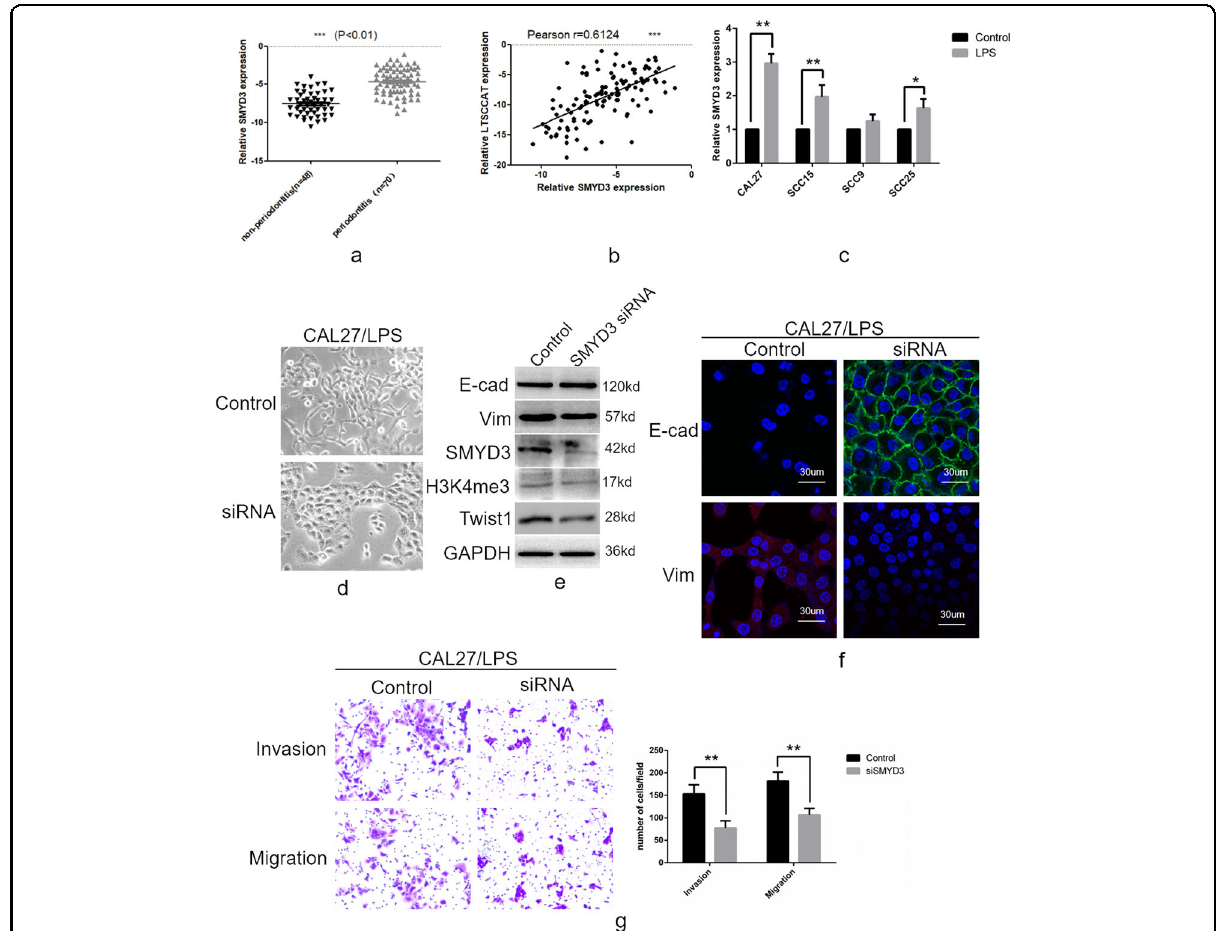
Fig. 4 SMYD3 promotes epithelial – mesenchymal transition in tongue squamous cell carcinoma. a The expression of SMYD3 in clinical specimens was detected by RT-QPCR, indicating that SMYD3 expression in TSCC tissues is higher in patients with periodontitis than in those without periodontitis. (** P < 0.01). b Correlation analysis between LTSCCAT and SMYD3 was performed in TSCC tissues. (** P < 0.01). c The expression of SMYD3 was reduced in the P.g-LPS-induced TSCC cell lines CAL27, SCC15, and SCC25. d SiRNA knockdown of SMYD3 expression in CAL27/LPS cells resulted in a cell morphology transition from an interstitial phenotype to an epithelial phenotype. (×200). e Western blot analyses showed that E- cadherin was upregulated after knockdown of SMYD3, while vimentin, SMYD3, H3K4me3, and Twist1 protein levels were downregulated. f Immuno fl uorescence experiments showed that E-cadherin increased and vimentin was decreased after knockdown of SMYD3. g Transwell invasion and migration assays indicated that the invasion and migration ability of CAL27/LPS was decreased after siRNA knockdown of SMYD3. Error bars represent the mean±S.D. from three independent experiments. (** P <